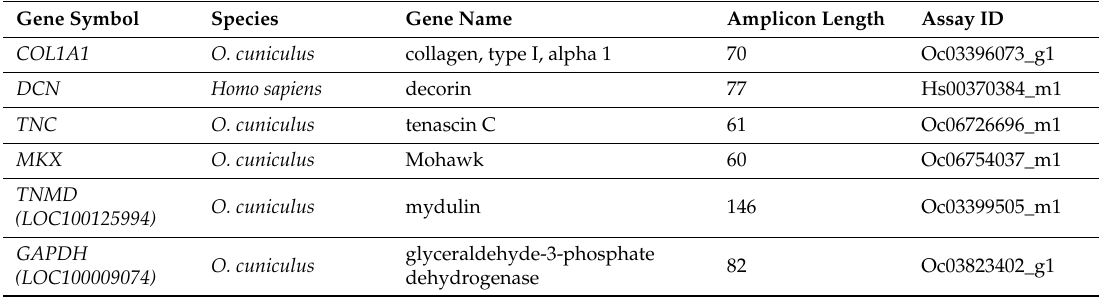
Table 1. Primers used in this